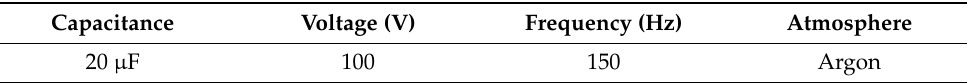
Table 2. Electro-spark deposition (ESD) process parameters employed to deposit high entropy alloy powders.